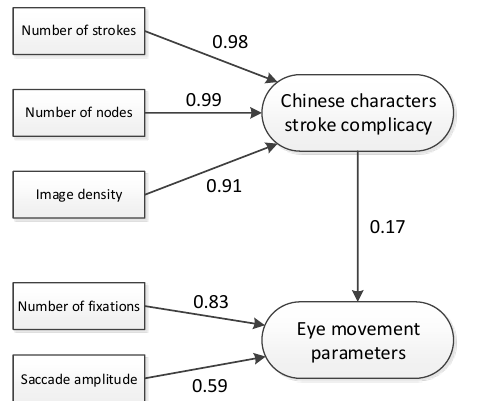
Fig.1. Structural Equation Modeling of Chinese character complicacy using eye movement parameters in Ma & Chuang (2015).